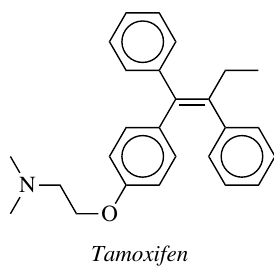
Figure 9. Chemical structure of Tamoxifen